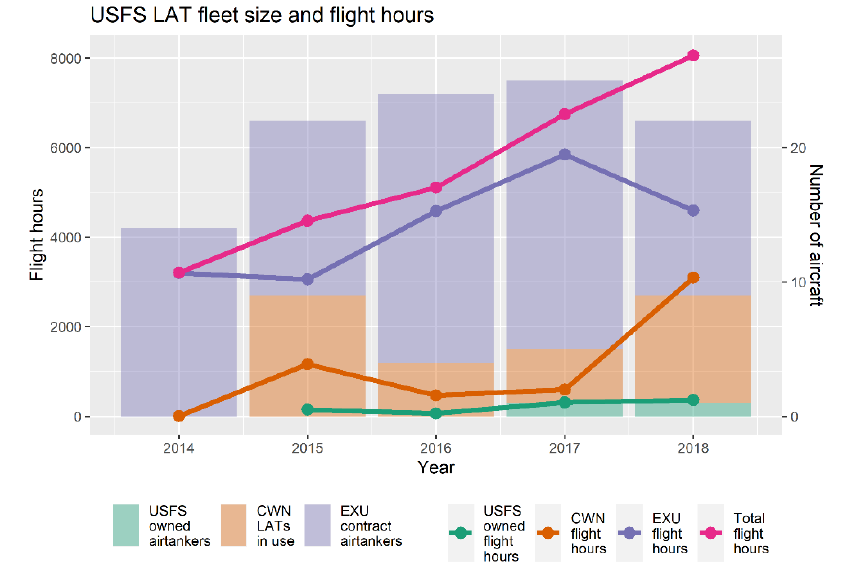
Figure 1. Forest Service large airtanker fleet size and use over time. Fleet size depicted by contract/ownership category (Exclusive Use—EXU; Call When Needed—CWN; United States Forest Service (USFS) Owned); fleet size data obtained from USFS Fire and Aviation Management Annual Aviation Reports (Available at: https://www.fs.fed.us/managing-land/fire/aviation/publications) and